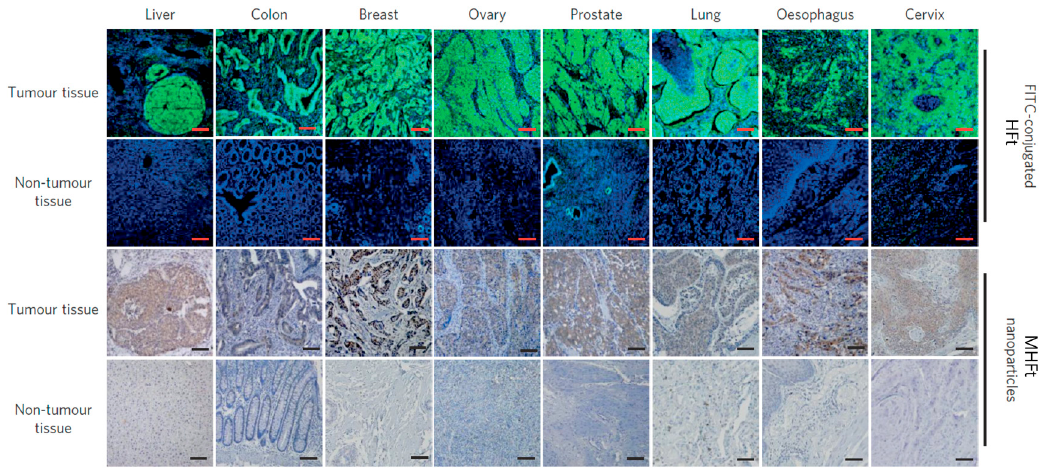
Figure 4. MFt can realize cancer diagnosis via tumor targeting and visualization. Reprinted with permission from Ref 41 Copyright 2012 Nature publishing group.